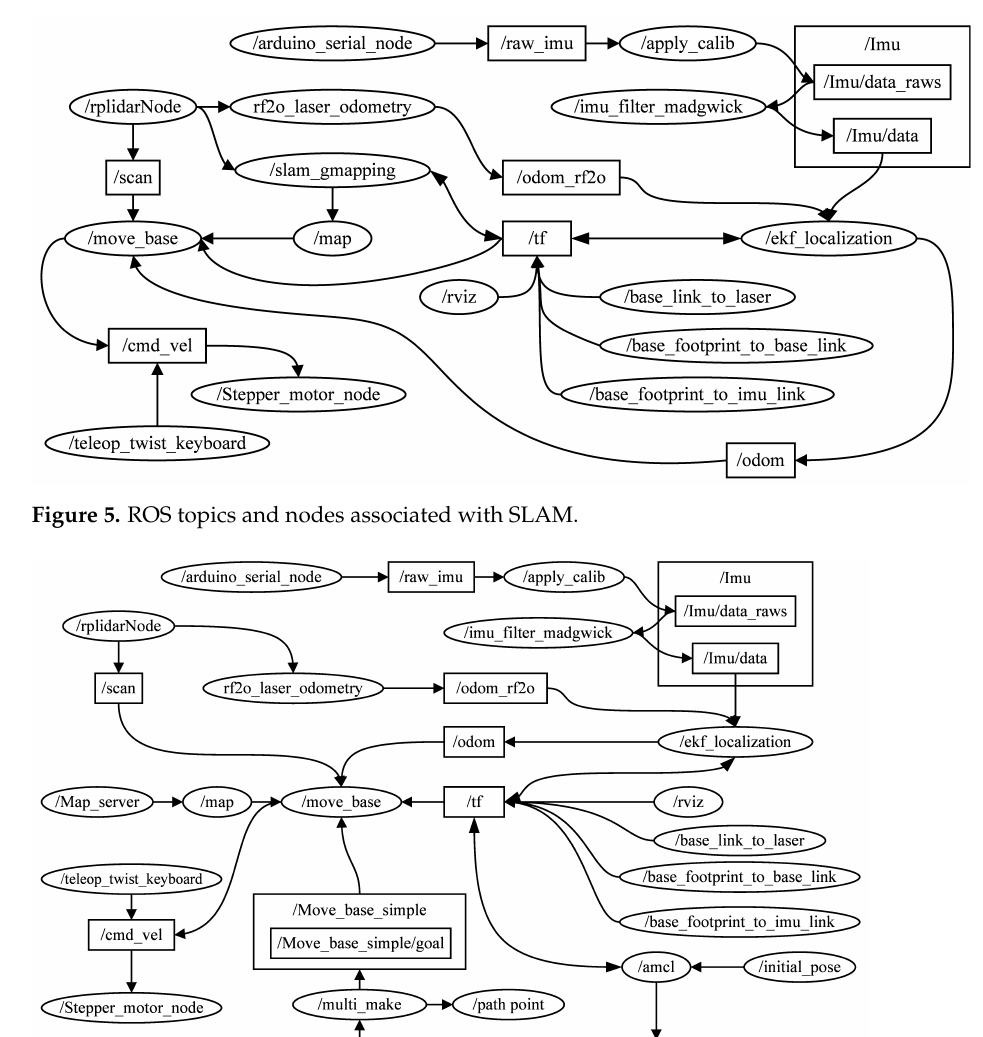
Figure 4. System structure of the Owlbot robotic platform.